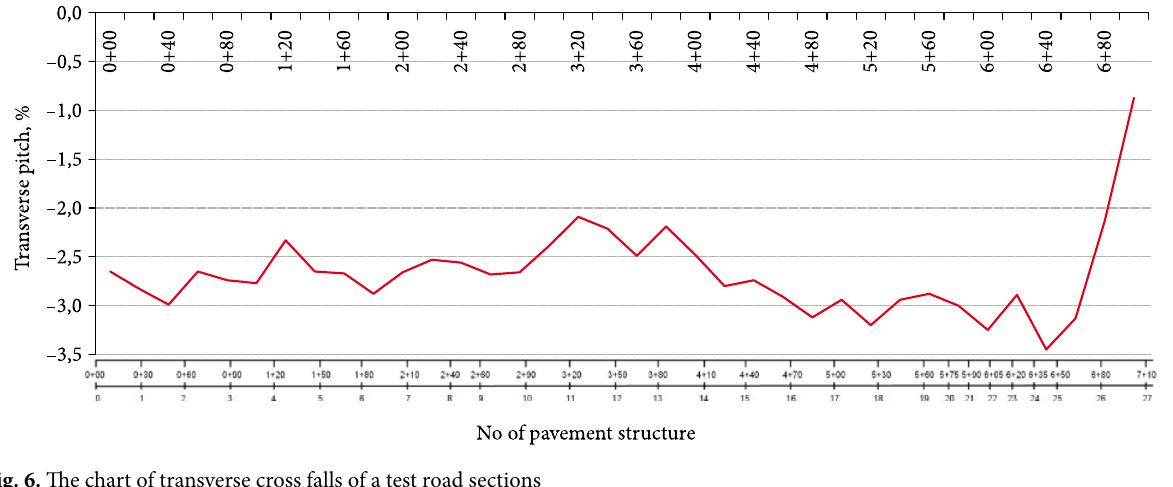
fig. 6. The chart of transverse cross falls of a test road sections